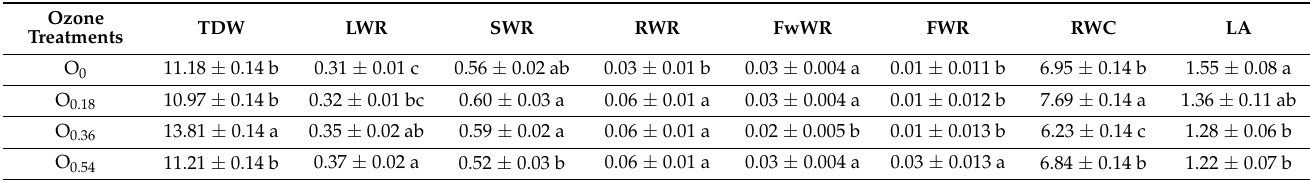
Table 6. Effects of O 3 dosage on S. lycopersicum seedlings’ total dry weight (g) (TDW), relative leaf weight ratio (LWR), stem weight ratio (SWR), root weight ratio (RWR), flower weight ratio (FwWR), fruit weight ratio (FWR), relative water content (RWC) and leaf area (LA) (m 2 ). The data recorded are the means ± standard deviation of four samples per treatment at the end of the experimental period. In each column, different letters denote statistically significant changes between treatments (LSD test; p < 0.05).